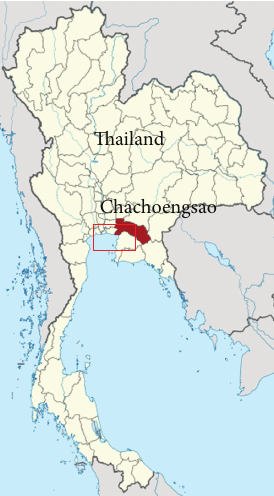
Figure 6: Maps of Thailand showing eroded area at Chachoengsao’s